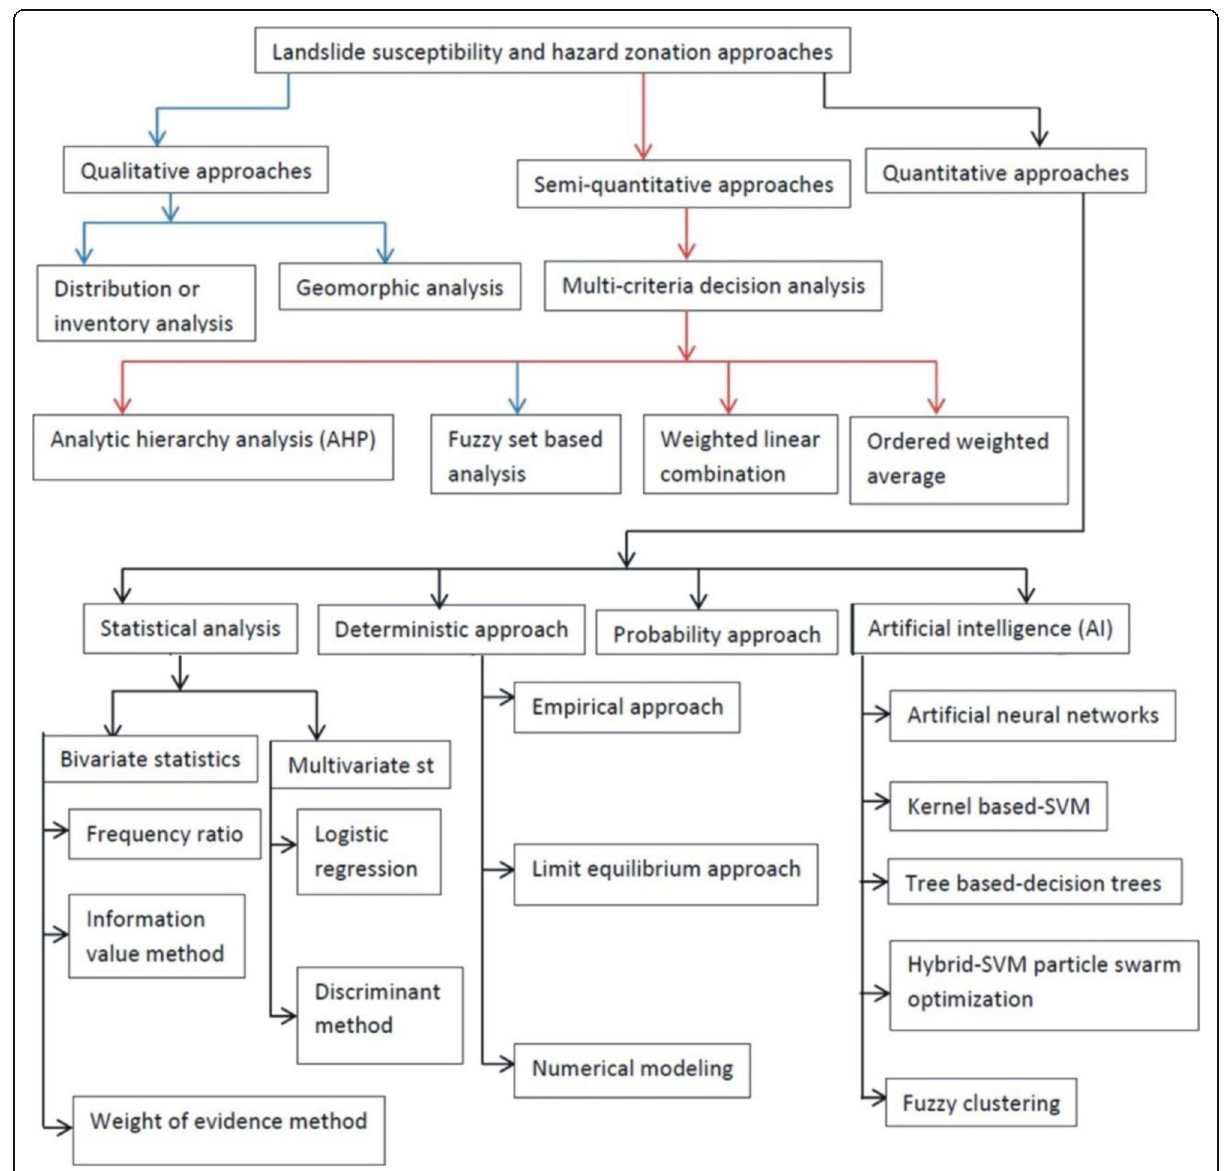
Fig. 1 Landslide susceptibility and hazard zonation